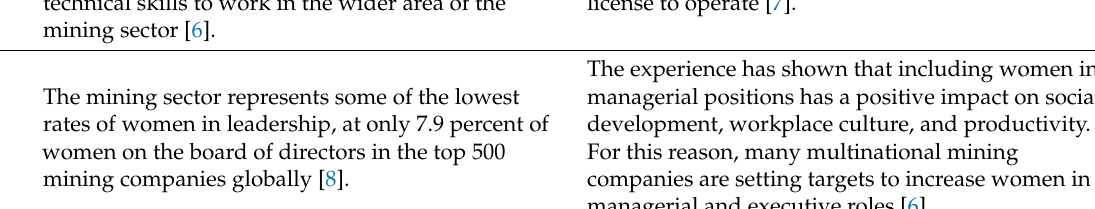
Table 1. Challenges to deal with in order to promote gender diversity in the extractive industry. Challenges